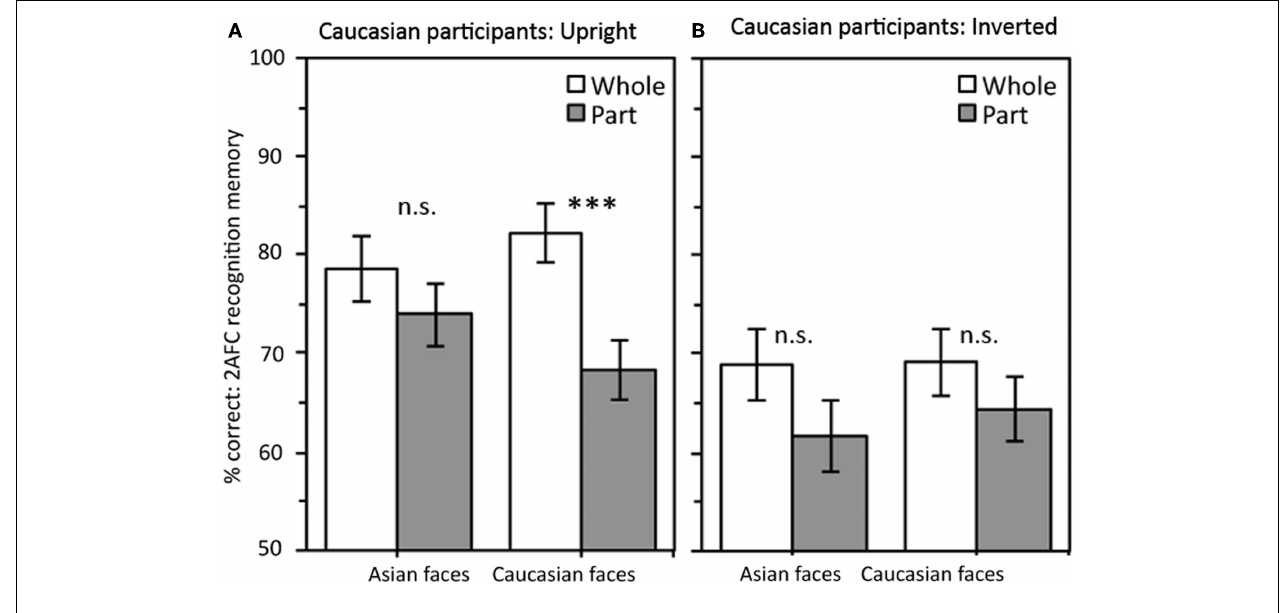
between subjects for the Caucasian participants. Error bars are as appropriate for making the within-subjects comparison between whole and part conditions (i.e., ± 1 SEM of the whole – part difference scores). *** p <